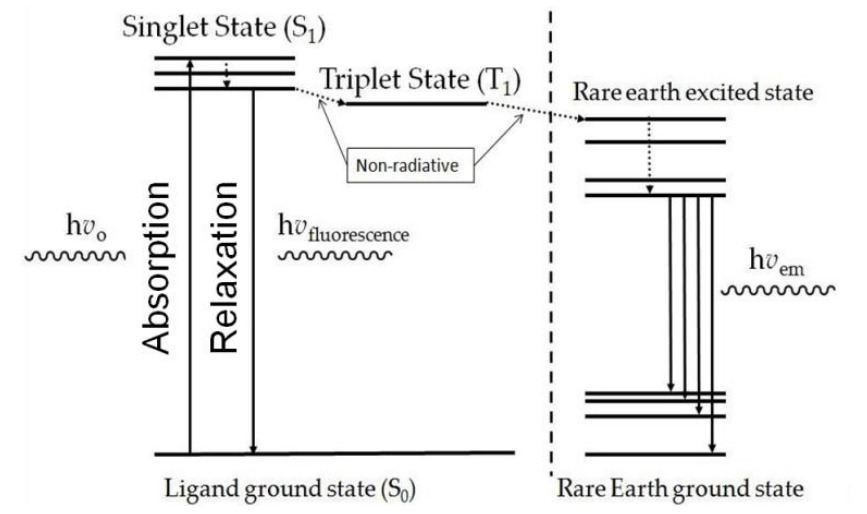
Figure 1. Ligand to rare-earth (RE) ion energy transfer diagram [16].